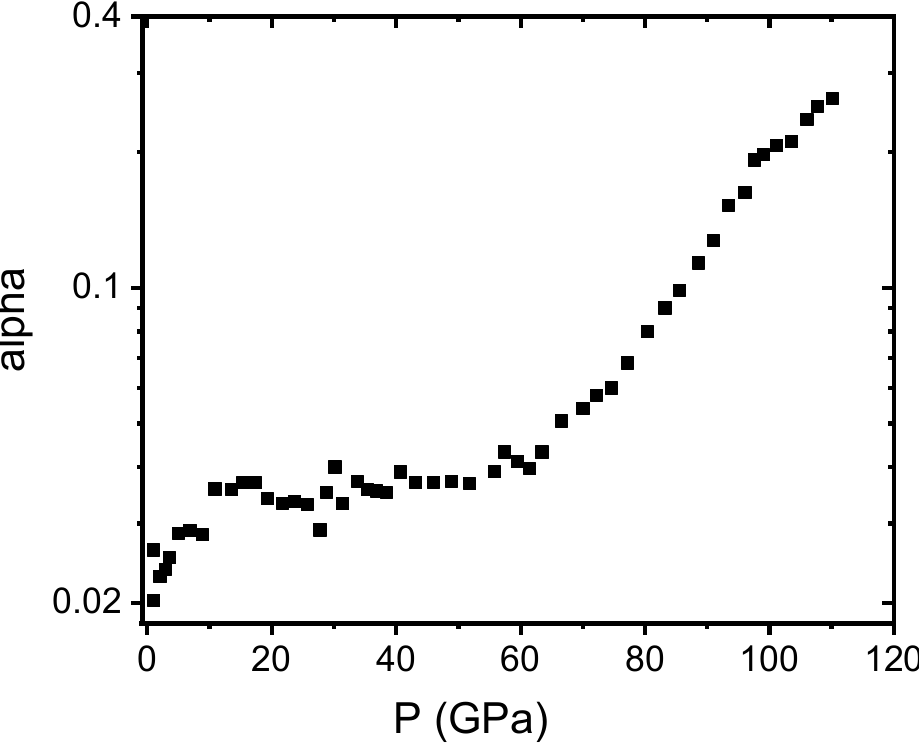
Figure 3. Pressure dependence of the stacking fault density calculated for the NANO sample using Equation (4), see text.